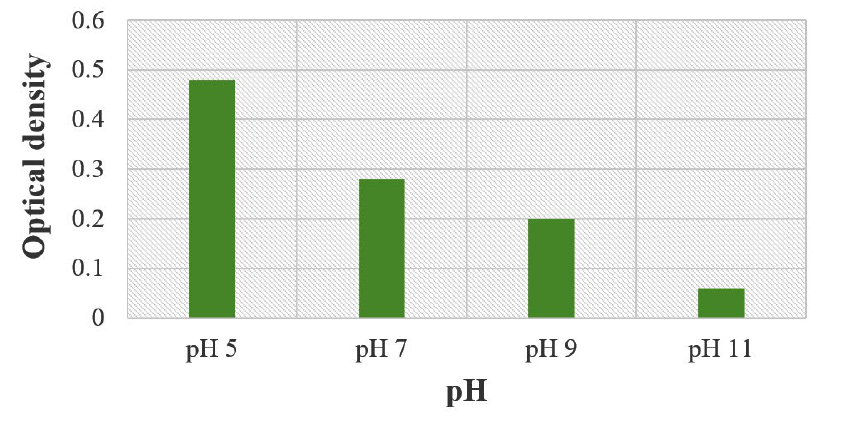
Fig.3. Effect of pH on growth of